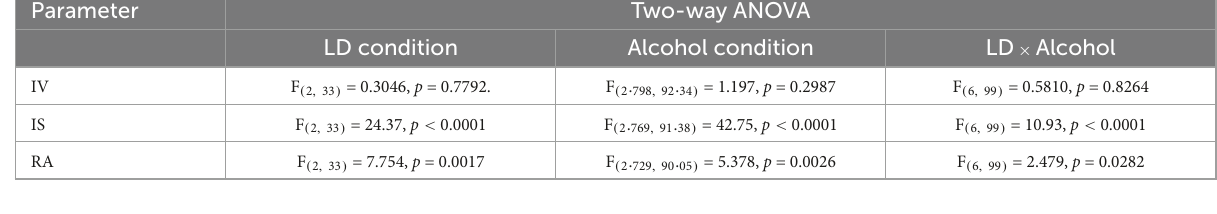
TABLE 1 Statistical results of circadian parameters for the combination of altered light-dark (LD) schedules and alcohol consumption.